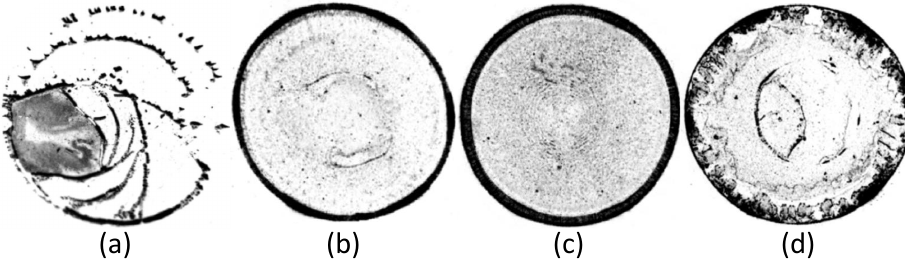
Figure 5. Deposition patterns of sessile droplets under-pressure conditions of ( a ) 750 mbar ( b ) 500